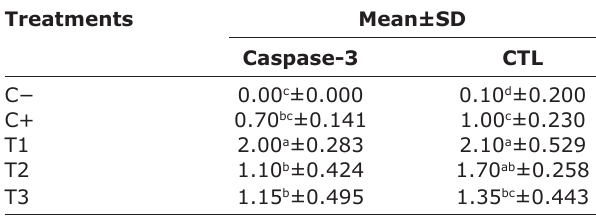
Table-1: Mean and SD caspase-3 and CTL expression. Treatments